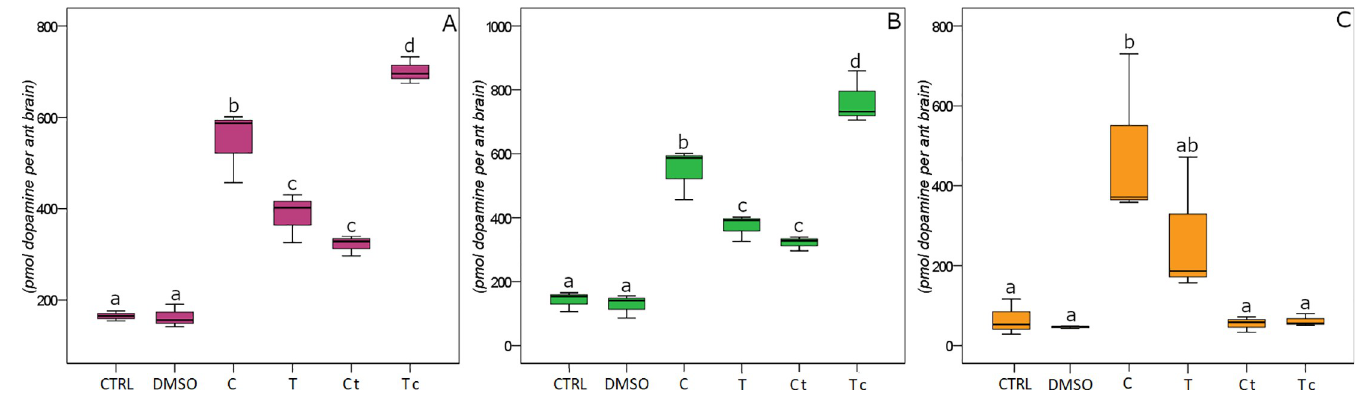
Fig 2. Dopamine content. Effects of treatments (C: carvacrol; T: thymol; Ct: 3:1 (v/v) carvacrol/thymol; Tc: 1:3 (v/v) carvacrol/thymol) and controls (CTRL and DMSO) on dopamine contents in ant brains of Formica cinerea (A), Tetramorium caespitum (B) and Myrmica scabrinodis (C). Values are expressed as pmol dopamine per ant brain. Boxplots show median, quartile, maximum and minimum values; different letters indicate significant differences (Tukey’s HSD post hoc, p < 0.05; S3 Table).